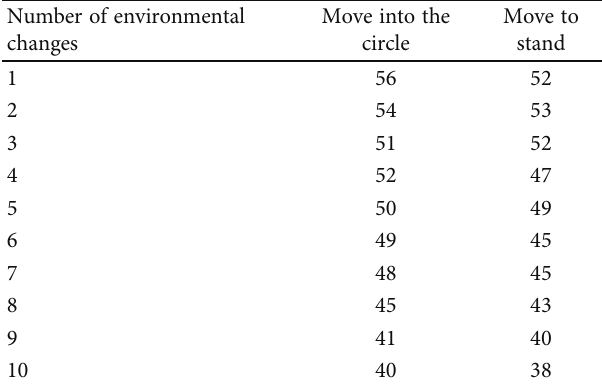
Table 1: Comparison of algorithm evolution algebra in this paper/ generation.